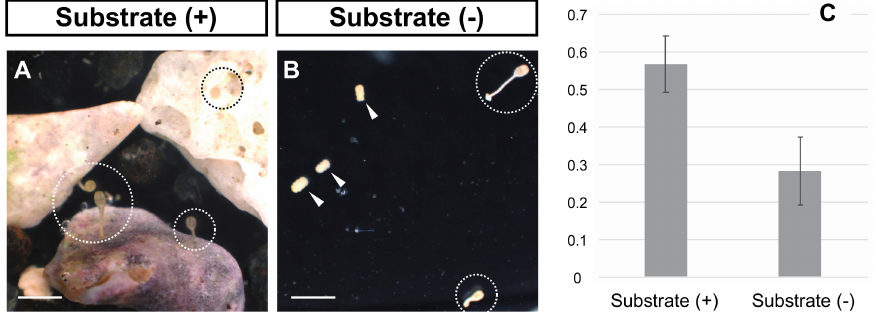
Figure 2. E ff ects of the presence or absence of substrates on settlement and metamorphosis. ( A , B ) indicate the doliolaria (arrowheads) or cystidean (dotted line circles) larvae incubated for six days with or without substrate, respectively. Scale bars: 1 mm. ( C ) shows the metamorphosis ratio for each